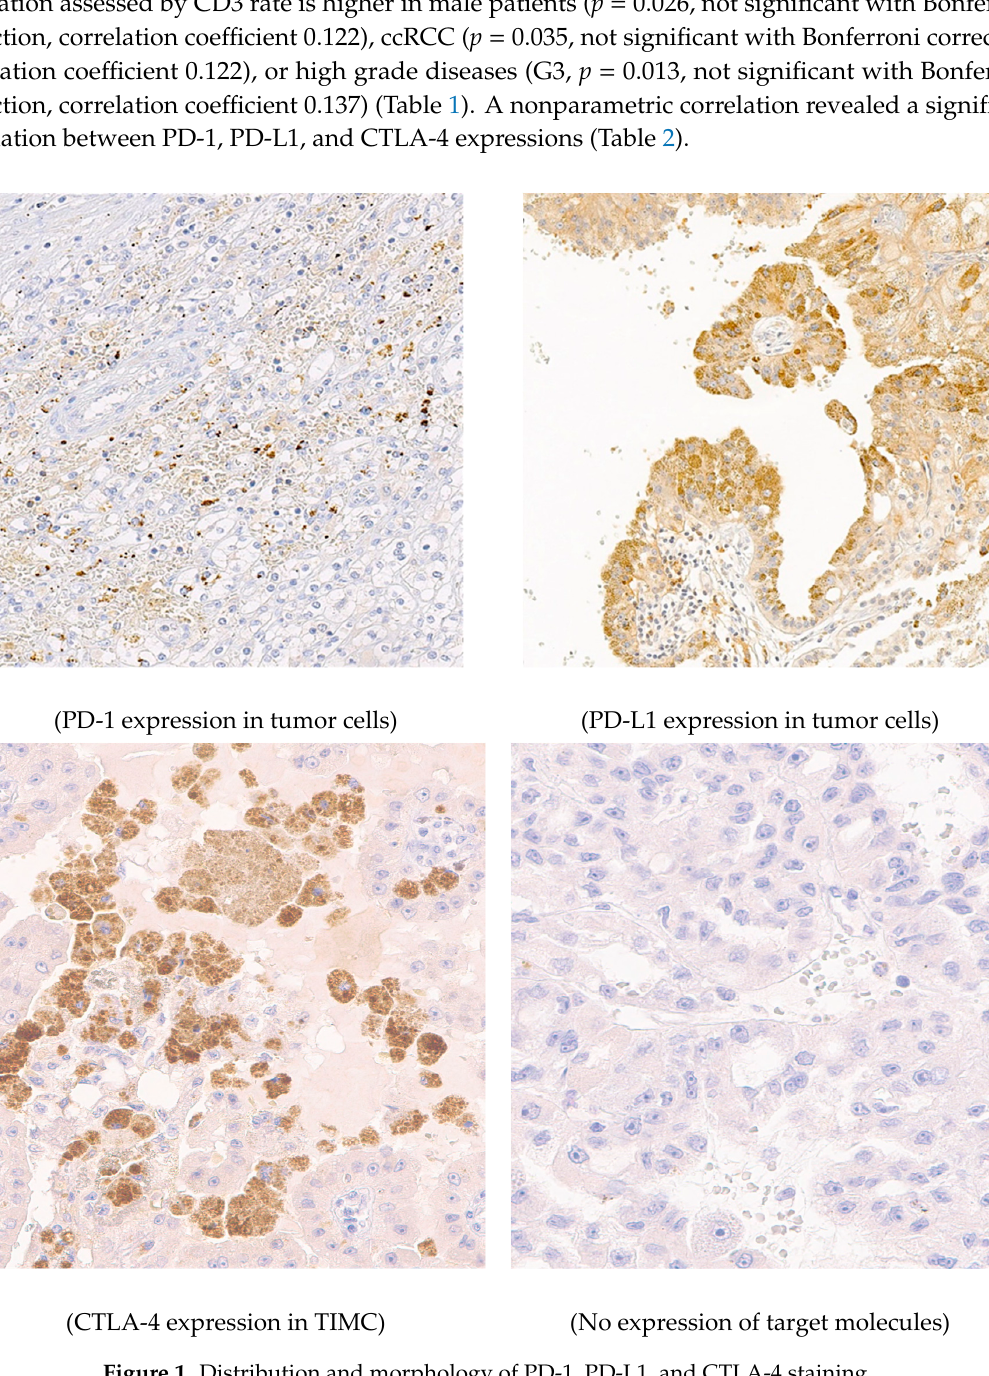
Figure 1. Distribution and morphology of PD-1, PD-L1, and CTLA-4 staining.